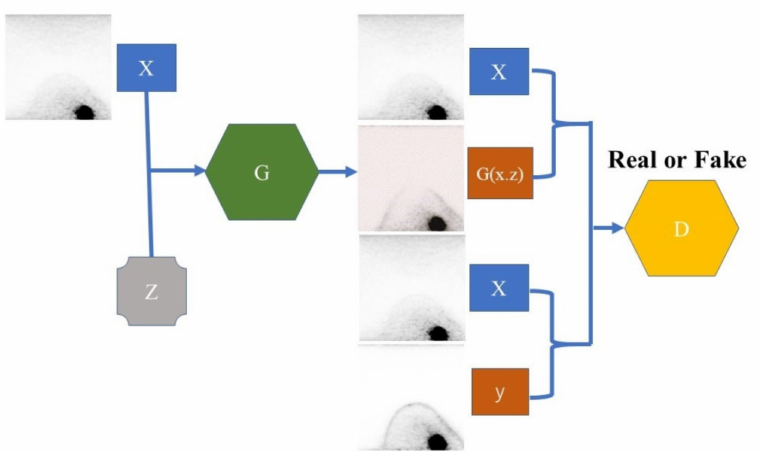
Figure 2. Structure of pix2pix. Generator G generates a synthetic image G (x, z) from an original image x and a noise vector z. Discriminator D classifies whether the “pair of original image x and real image y” and the “pair of original image x and synthetic image G (x, z)” are real. This structure allows Generator G to learn the relationship between image pairs to generate realistic synthetic images from the original